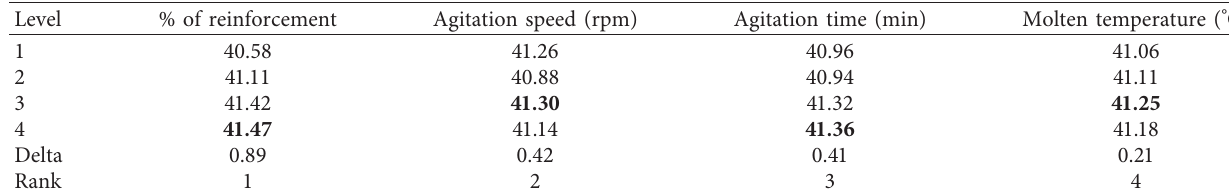
Table 9: Response table for signal to noise ratios (Vickers hardness test); larger is better.